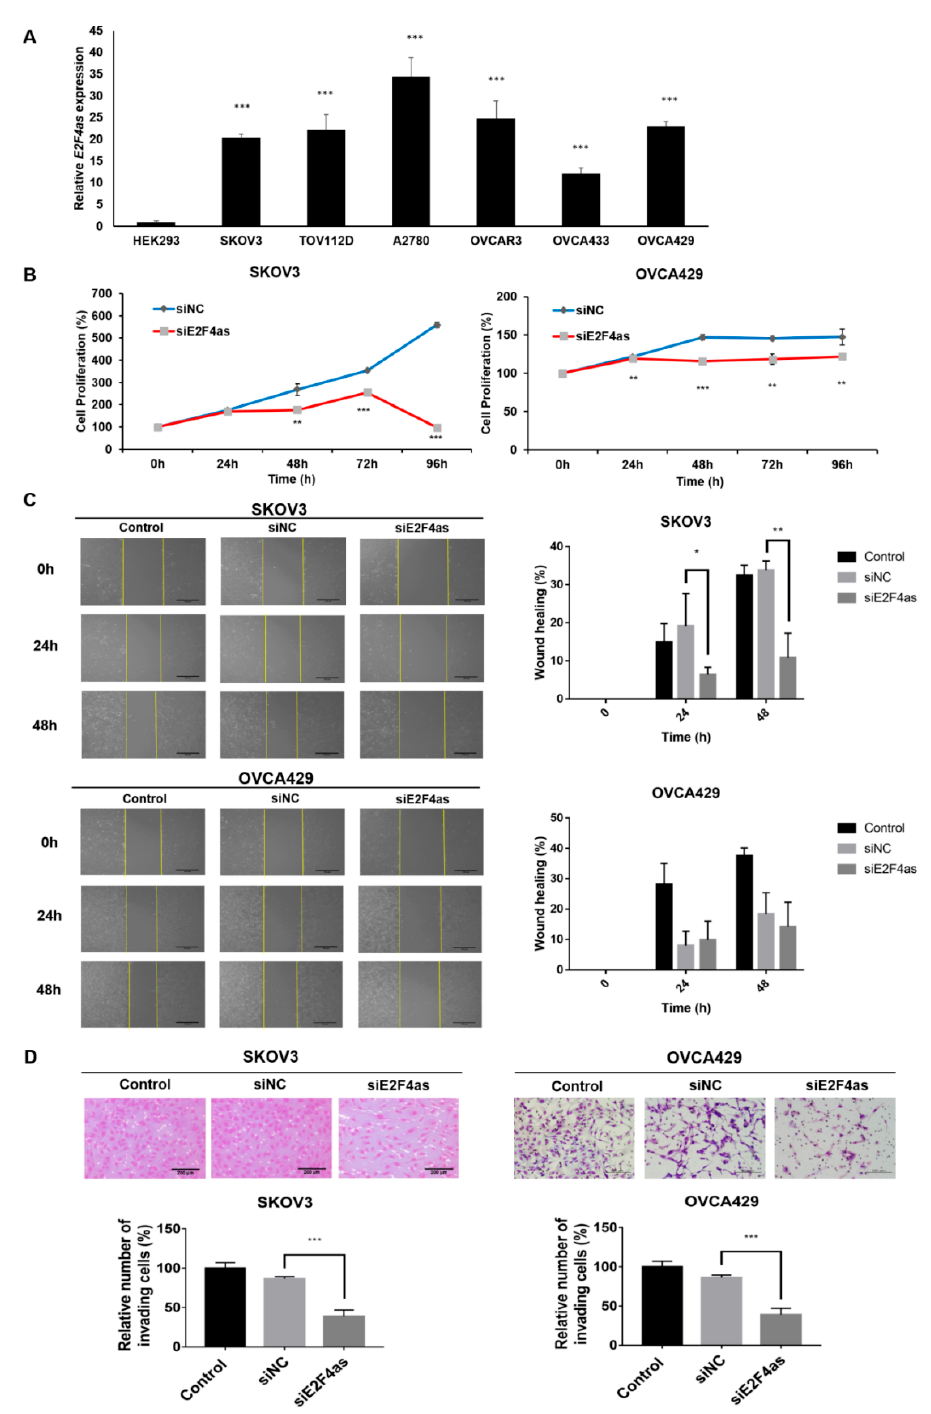
Figure 3. Inhibition of E2F4as could suppress proliferation and metastasis of ovarian cancer cells. ( A ) Expression of lncRNA E2F4as in six ovarian cancer cell lines and one human embryonic kidney cell line was detected by qRT-PCR. ( B ) CCK-8 assay used to detect proliferation ability of SKOV3 and OVCA429 cells. ( C ) Wound healing assay used to measure migration ability. Yellow colour line indicates width of the wound. ( D ) Cell invasion observed under optical microscope. Matrigel invasion assay used to determine invasion after 48 h of incubation of E2F4as knockdown SKOV3 and OVCA429 cells. Matrigel invasion assay results showing percentage of each cell line. Data expressed as mean ± standard deviation; * p < 0.05, ** p < 0.01, *** p < 0.001 vs.